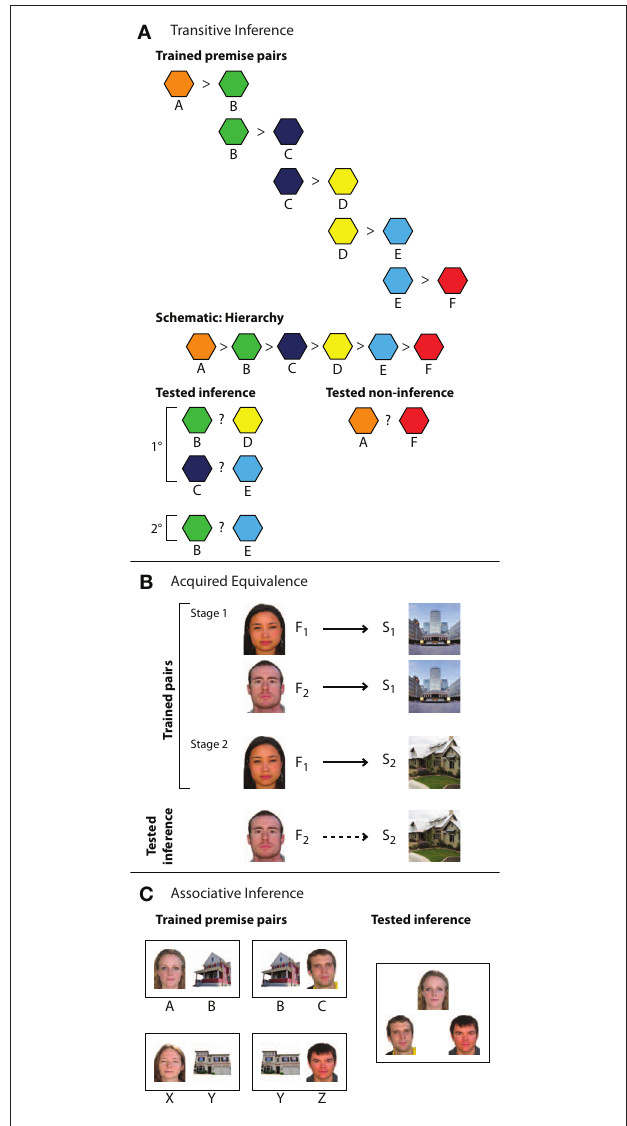
FIGURE 1 | Inference tasks. (A) Transitive inference task with six elements. A set of overlapping training pairs forms an ordered hierarchy of relationships. Participants learn each individual training pair via feedback-based learning (e.g., A > B) and are then tested on novel inference and novel non-inference judgments. Items in inferential probe trials may be separated by one element in the hierarchy (e.g., B ? D, indicated as 1 ◦ ) or two elements (e.g., B ? E, indicated as 2 ◦ ). Novel non-inferential probes test knowledge of the relationship between the end items of the hierarchy (A ? F). (B) Acquired equivalence task. In stage one of training, participants are trained via feedback to associate two faces (F 1 and F 2 ) with a particular scene (S 1 ). In stage two, participants learn to select a second scene (S 2 ) when cued with one of the faces (F 1 ). Inference is then measured as the proportion of trials on which participants choose S 2 when cued with F 2 . The schematic depicts trained stimulus–response relationships (solid black arrows) and inferential relationships (dashed black arrows). (C) Associative inference task. Participants learn an overlapping set of associations (here, face–house associations), in which two stimuli (a man and a woman) are associated with a common third item (a house). Novel inference trials evaluate knowledge for the indirect relationship between items (who lives together in the same